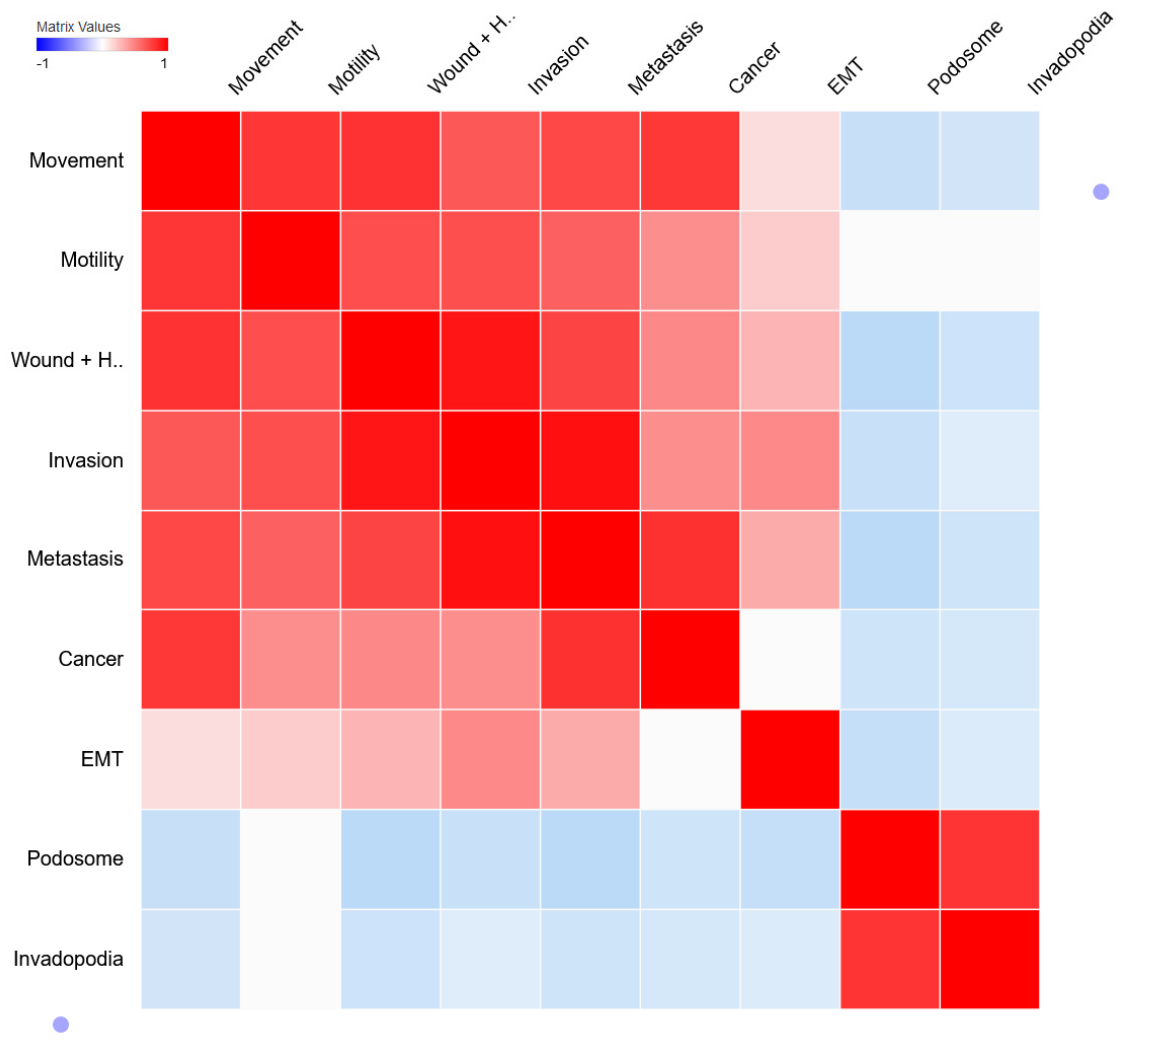
Figure 2. Correlation between metastasis-related processes. The column similarity matrix represents the similarity between metastasis-related processes whereas red (1), white (0), and blue ( − 1) represent positive, neutral, and negative correlations (measured as 1—cosine-distance).